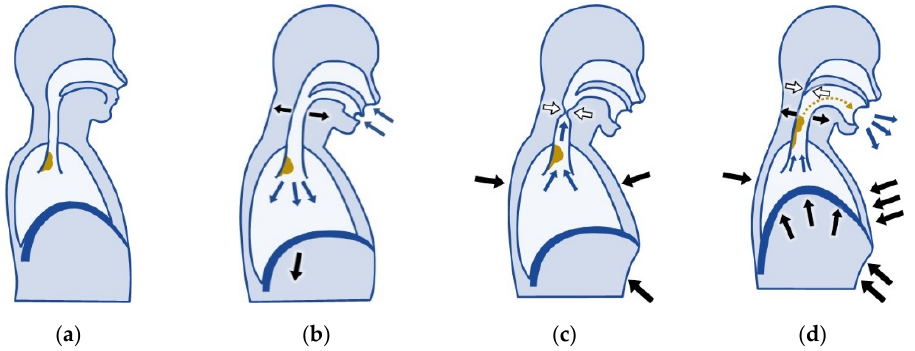
Figure 1. Four phases of a cough [11]. ( a ) Irritation phase. ( b ) Inspiration phase. ( c ) Compression phase. ( d ) Expulsion phase. The blue arrows represent air flow. The black arrows represent movements of each part. The white arrows represent airway closure. The brown parts represent mucus and foreign material. The brown dots represent the movement of mucus and foreign material from the lower airway to the upper airway. Modified from Cherniack RM, Naimark A: Respiration in health and disease, Philadelphia, 1972, WB Saunders.